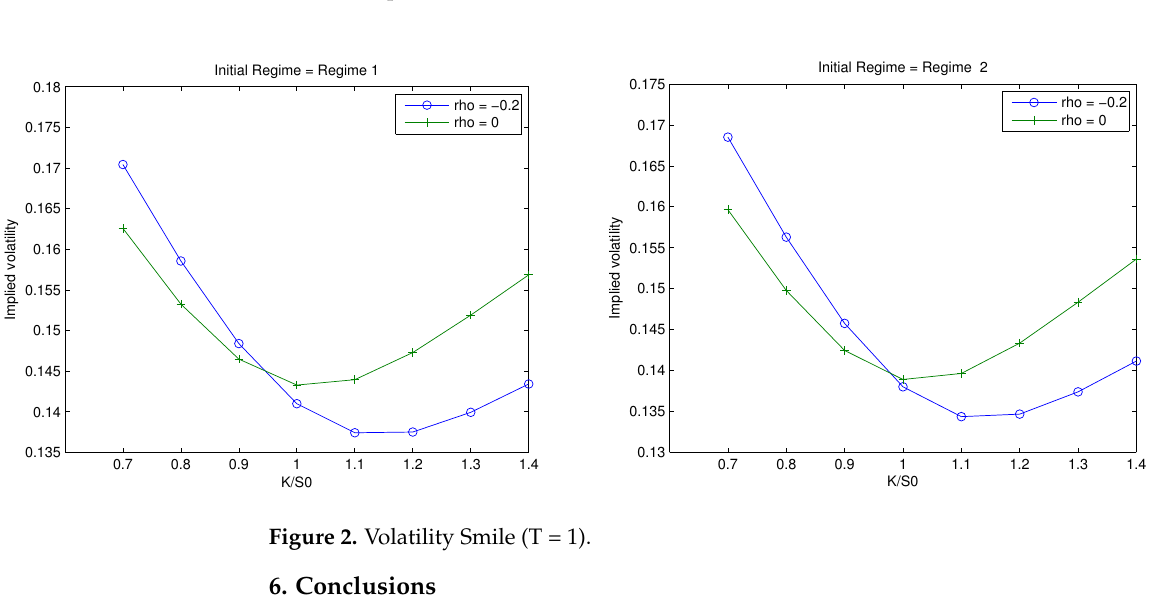
Figure 1. A picture of a Table 2.